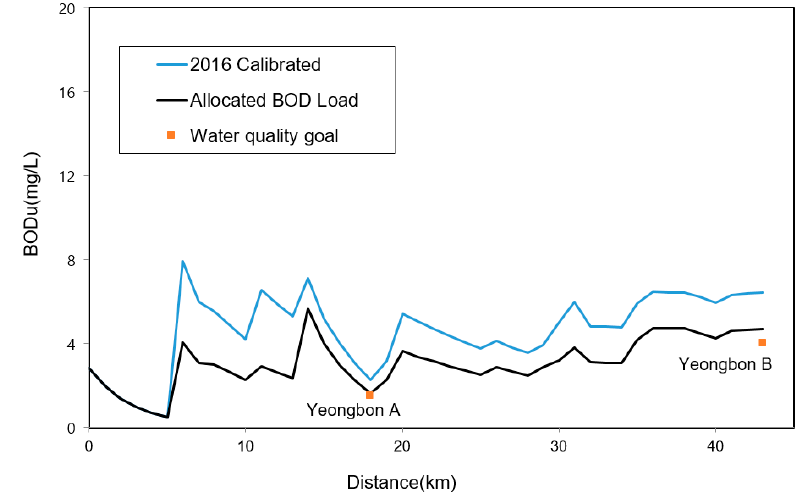
Figure 6. Water quality distribution in the Yeongsan River after waste load allocation (WLA) application according to the fuzzy model. The water quality goal is the target water quality for BODu in the fuzzy WLA model proposed in this study. The allocated BOD load is the water quality distribution in the Yeongsan River calculated from the fuzzy WLA model.